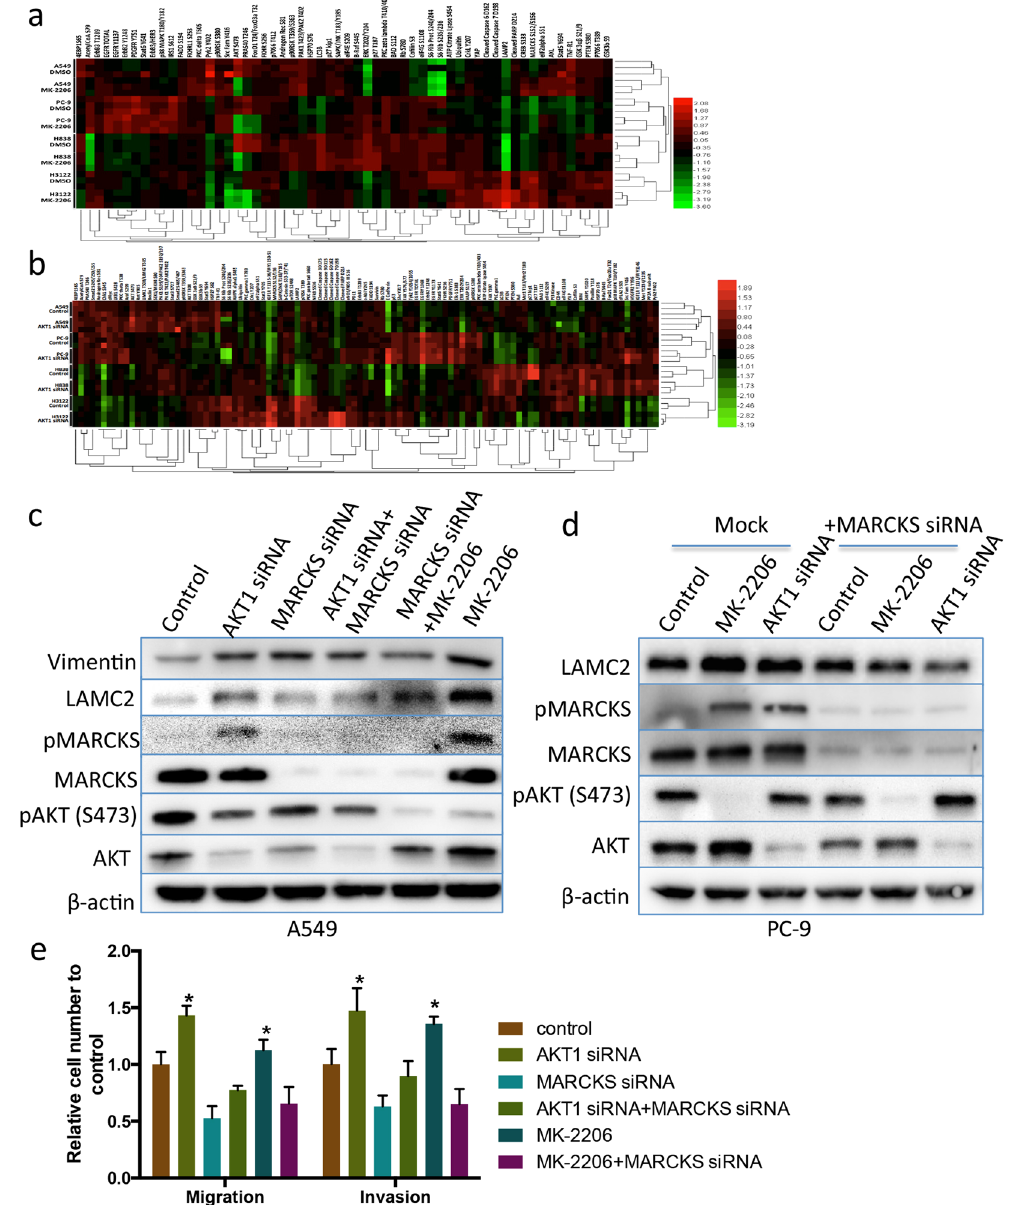
Figure 5. AKT1 inhibition activates MARCKS to promote migration and invasion. Heat map of proteins with significant changes in the RPPA assays of A549, PC-9, H838 and H3122 treated with vehicle or ( a ) 1 μ M MK-2206 for 24 hours or ( b ) 10 nM AKT1 siRNA pool for 48 hours. Relative protein levels are color-coded: low (green), median (black), and high (red). Western blot analysis of phospho-MARCKS and other indicated proteins in ( c ) A549 cells and ( d ) PC-9 cells treated with AKT1 siRNA or MK-2206 with/without MARCKS siRNA. ( e ) Migration and invasion assays of A549 cells treated with AKT1 siRNAs or MK-2206 with/without MARCKS